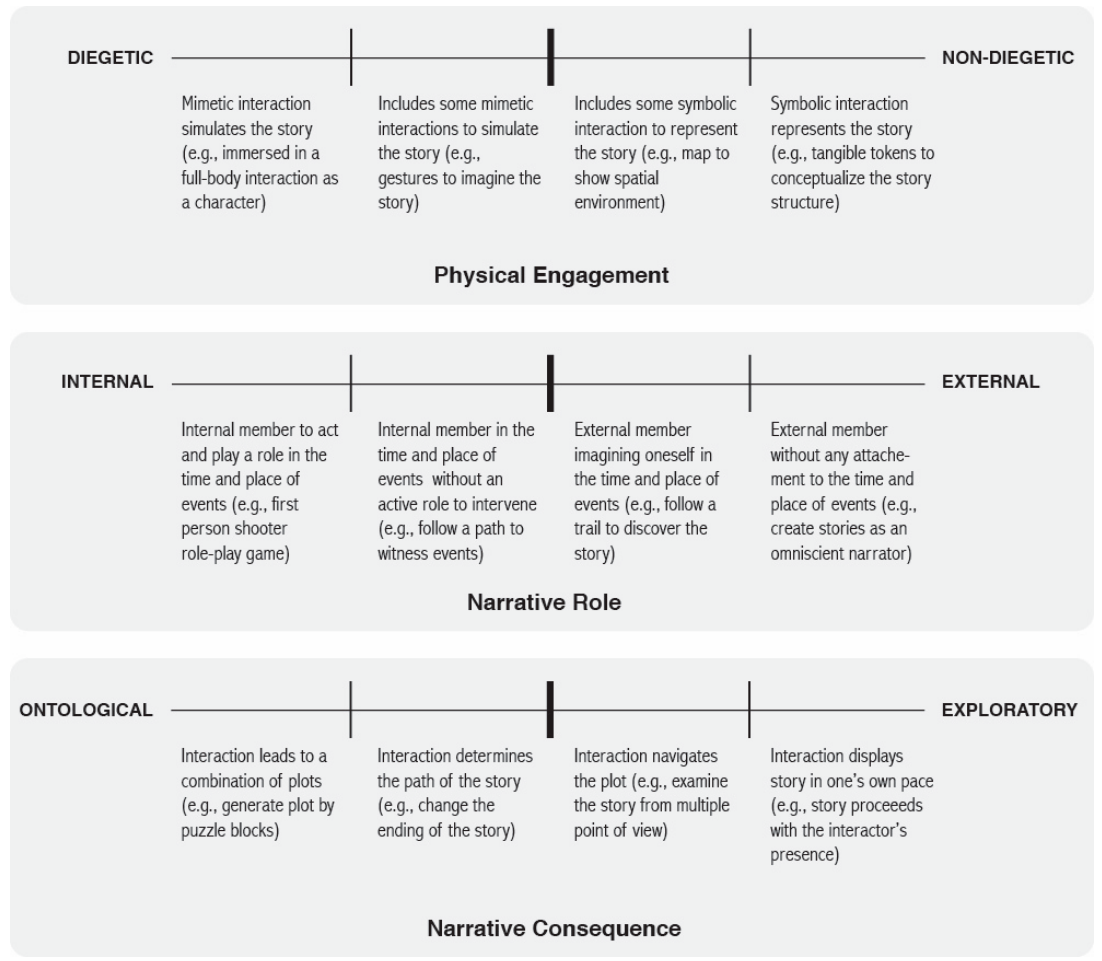
Figure 1. Three spectra comprising the Tangible and Embodied Narrative Framework (TENF).